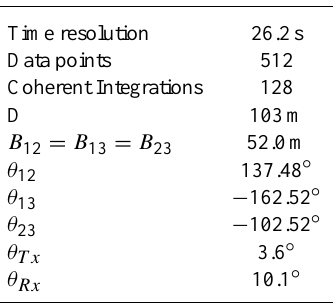
Table 1. Parameters for an experiment with the MU radar for com- parison of experimental wind component variance with theoreti- cally estimated variance. D is the transmitter antenna diameter, θ Tx and θ Rx are the transmitter and receiver antenna half-power beam- width and field-of-view, respectively. Figure 2 shows the experi- ment antenna and baseline arrangement.